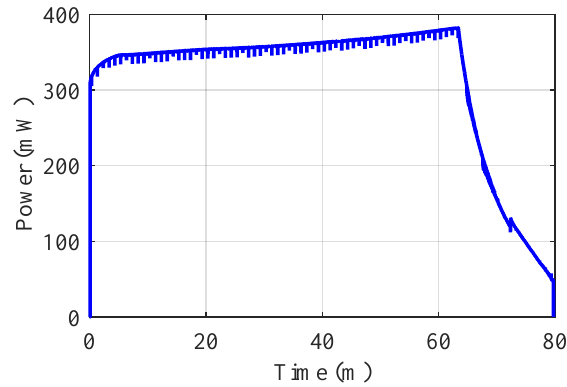
Figure 9. Charging power of a full charging cycle.